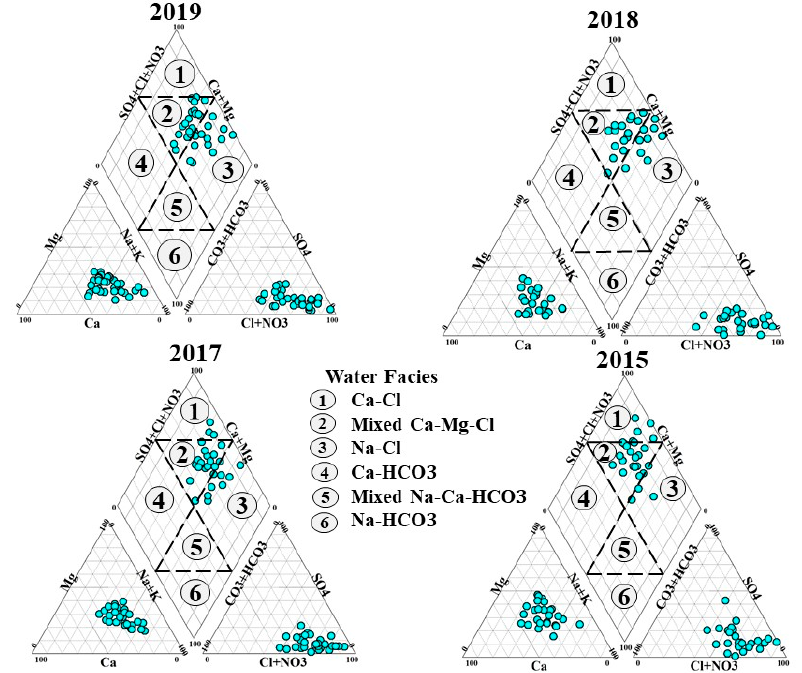
Figure 3. Piper diagrams showing hydrogeochemical facies of Plio-Quaternary aquifer within the Essaouira basin for the four sampling campaigns.